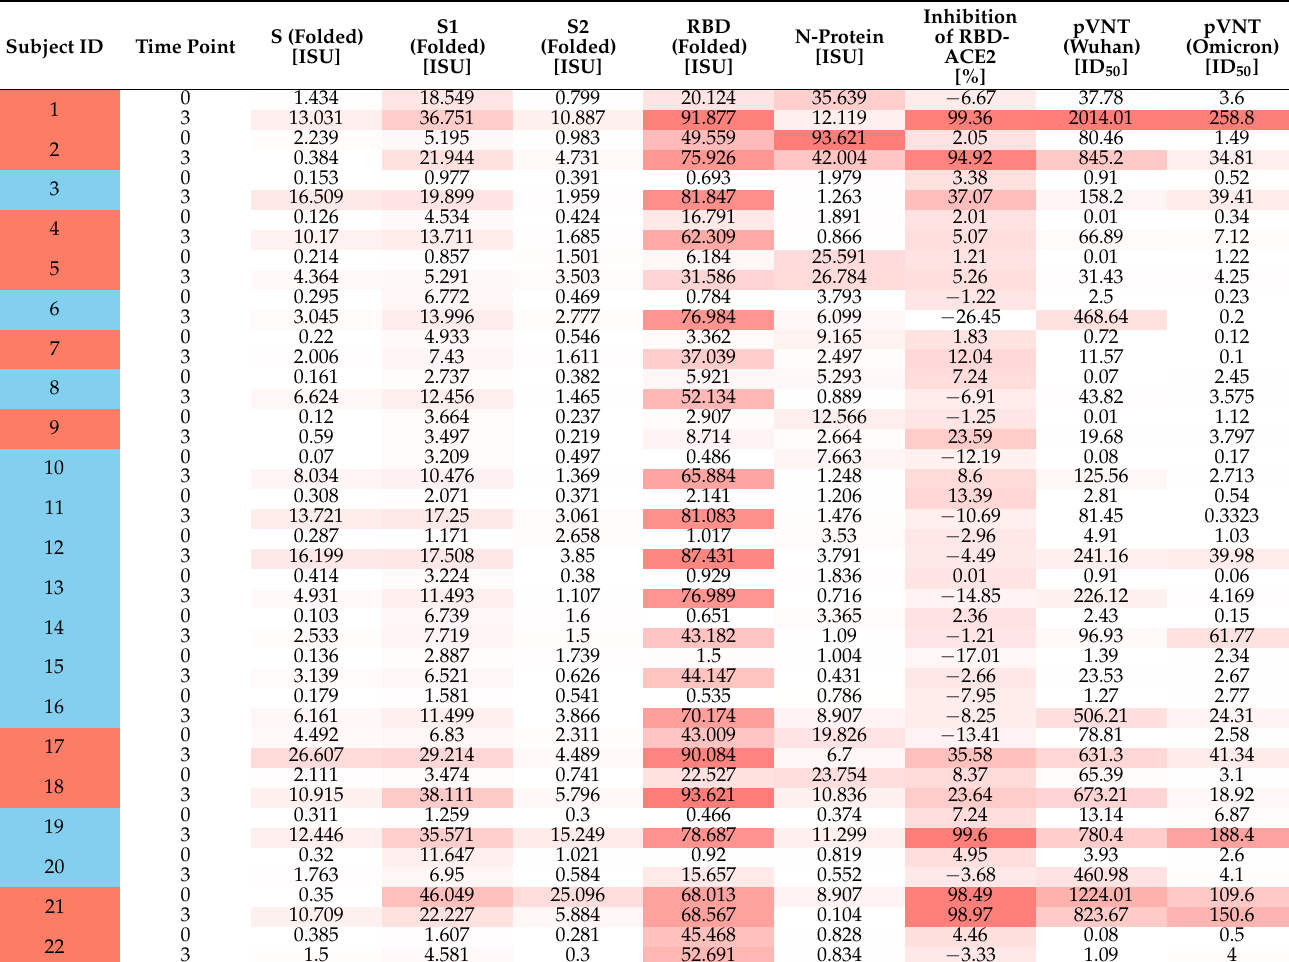
Table 2. Comparison of IgG levels specific for S, S1, S2, and RBD measured by micro-array with inhibitions of RBD binding to ACE2 and virus neutralization titers (Wuhan-Hu-1, Omicron) deter- mined for plasma from the investigated subjects. Heat mapping was performed for each parameter separately using Excel. The highest level was considered dark red and the lowest